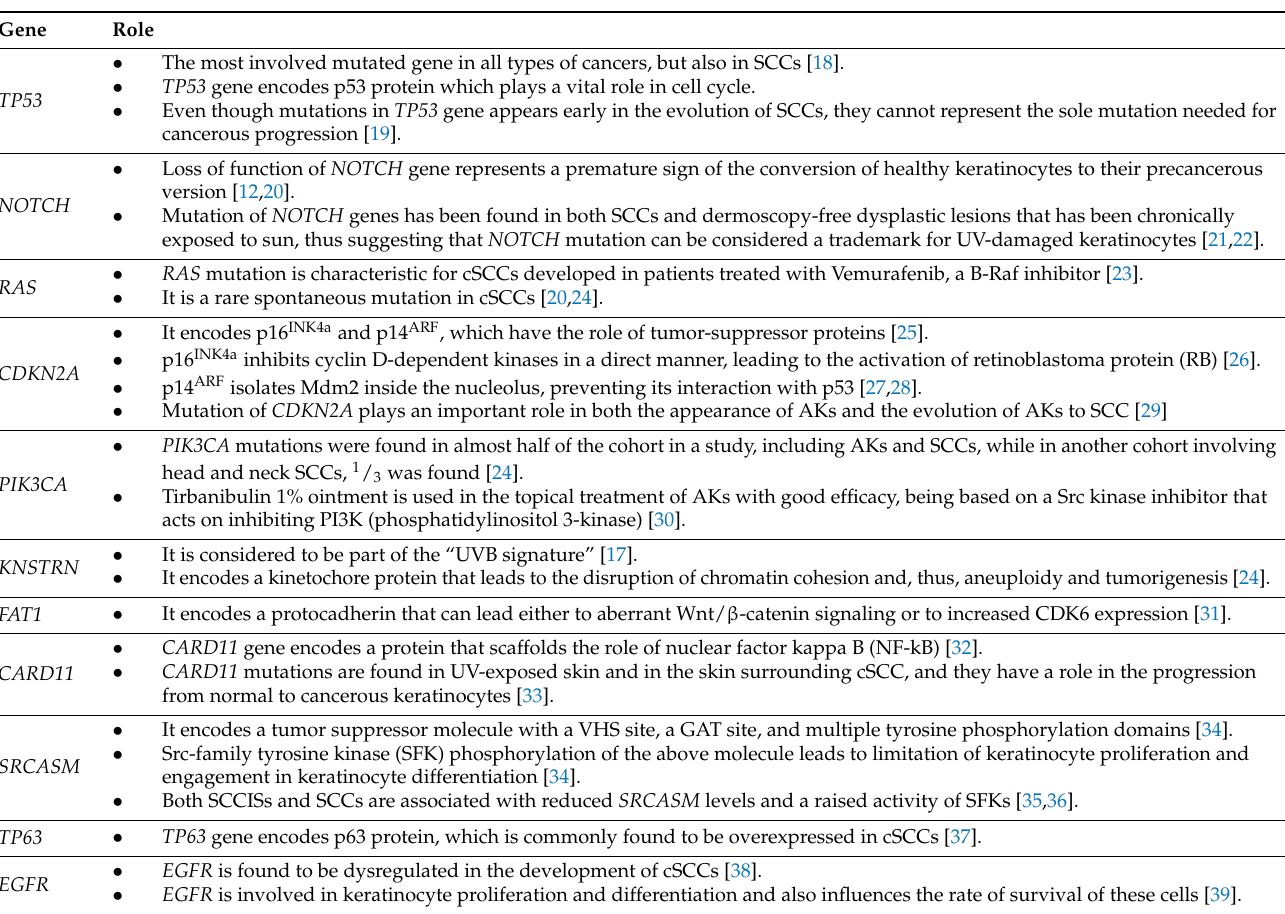
Table 1. Mutated genes involved in the development of AKs and